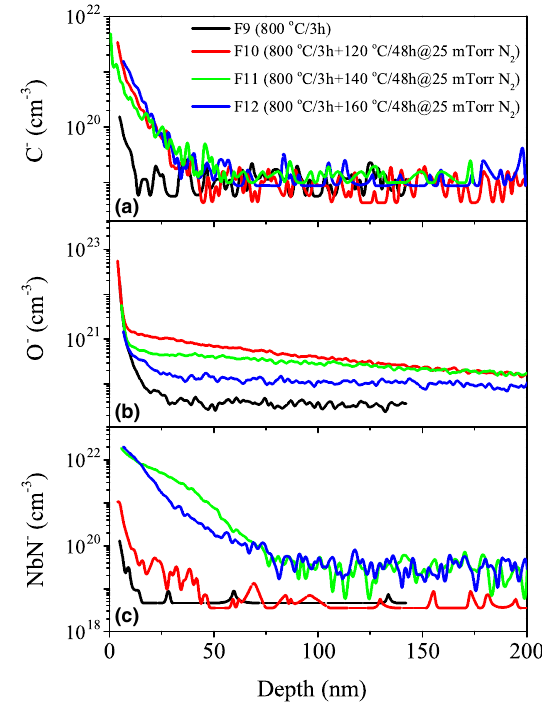
FIG. 7. SIMS depth profile of (a) carbon, (b) oxygen and (c) nitrogen measured in samples F9 –